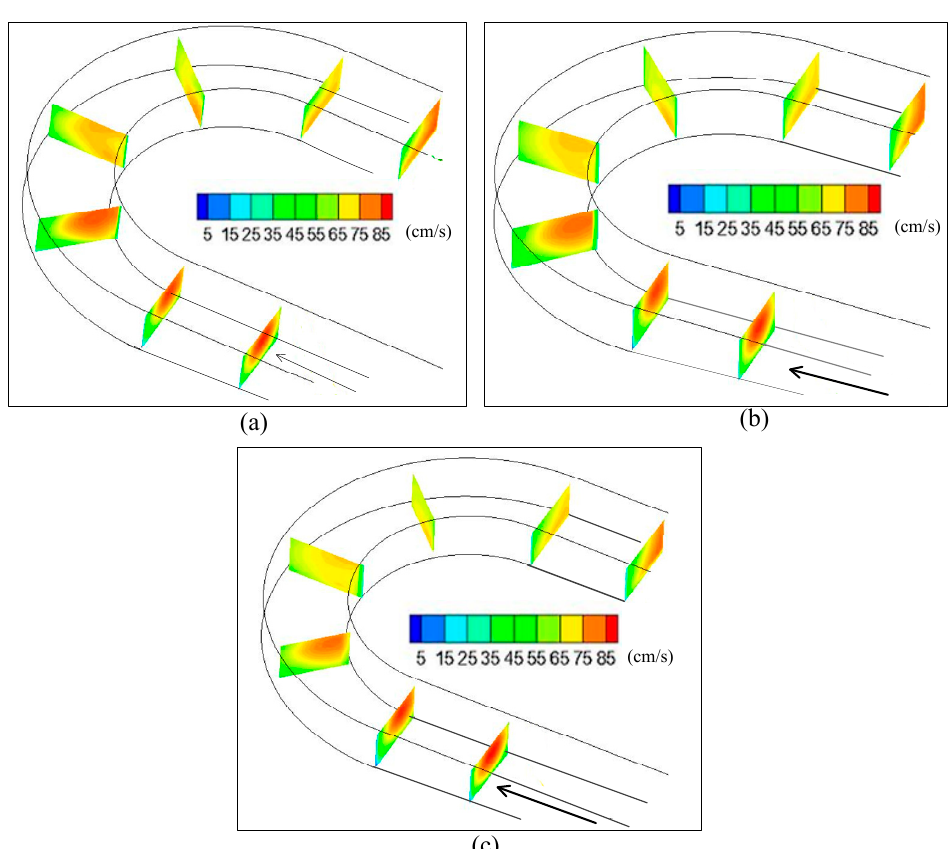
Figure 5. Map of section flow rate obtained by different grid simulations: ( a ) grid 1; ( b ) grid 2; ( c ) grid 3.